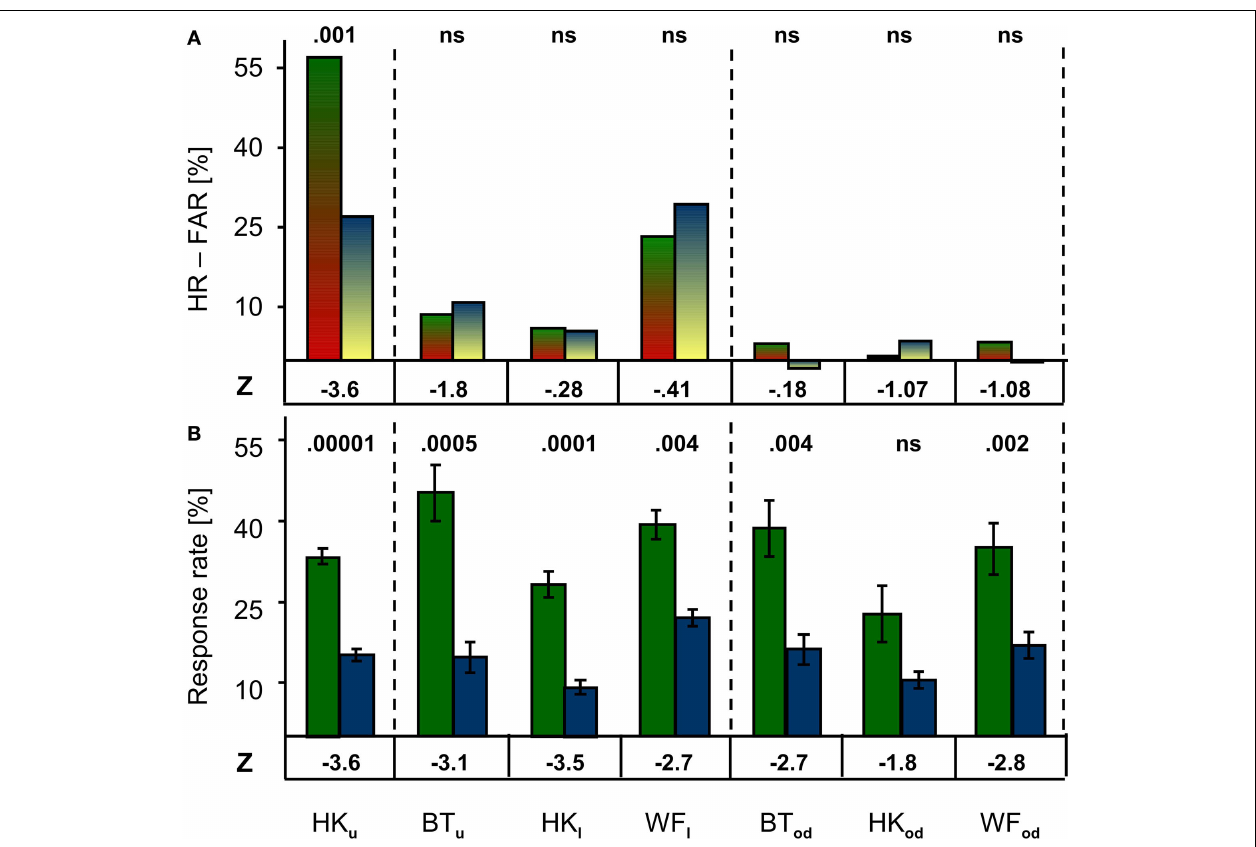
FIGURE 3 | Comparison of performance and response frequency in cued and un-cued conditions. (A) When False Alarm Rates were deducted from Hit Rates to allow comparison of cued (green/red) and un-cued (blue/yellow) conditions, no signifi cant effect of cueing was revealed at any position